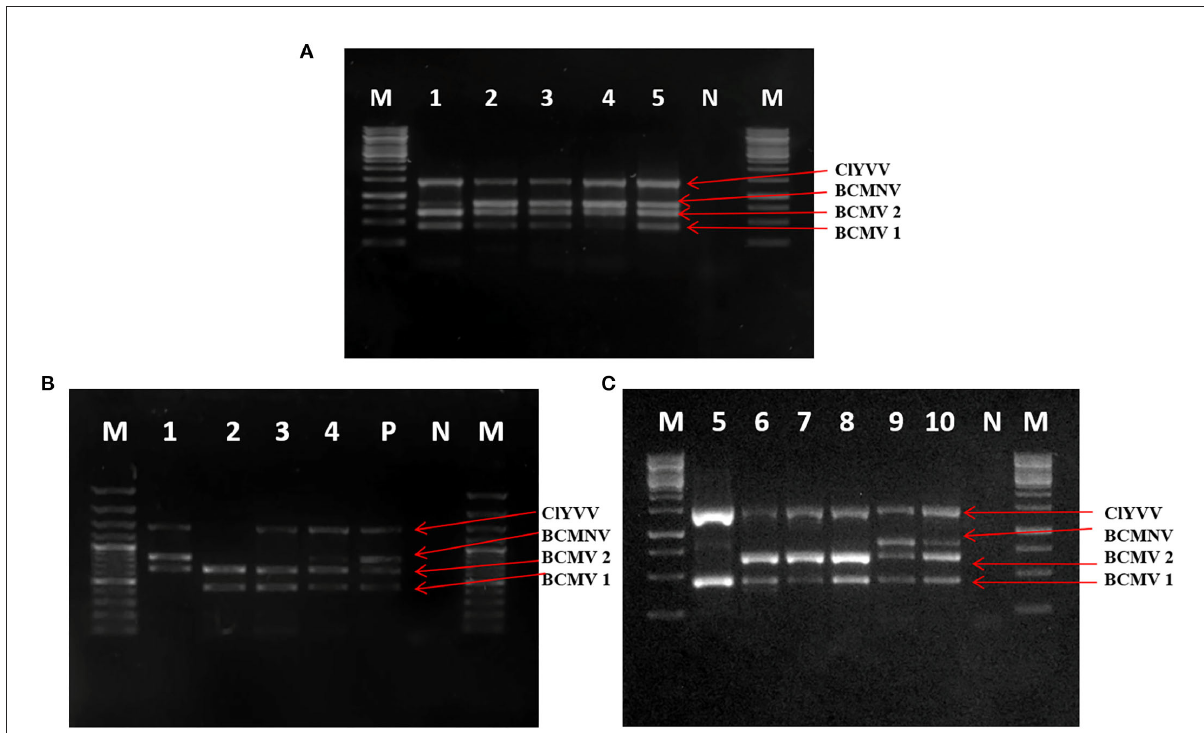
FIGURE7 Optimization of multiplex PCR using specific primers of BCMV 1, BCMV 2, BCMNV, and ClYVV in RT-PCR assay. (A) Lane 1–5: PCR product using RNA with BCMV 1, BCMV 2, BCMNV, and ClYVV infection from positive control as a template for assay. (B,C) Simultaneous detection of bean viruses in multiplex RT-PCR by using RNA extracted from 10 field samples collected from SKUAST-K. Lanes 1–10 are amplified products of representative field samples. M is 1Kb molecular marker, P is positive control obtained from infected plants with all three viruses, and N is a negative control from a healthy